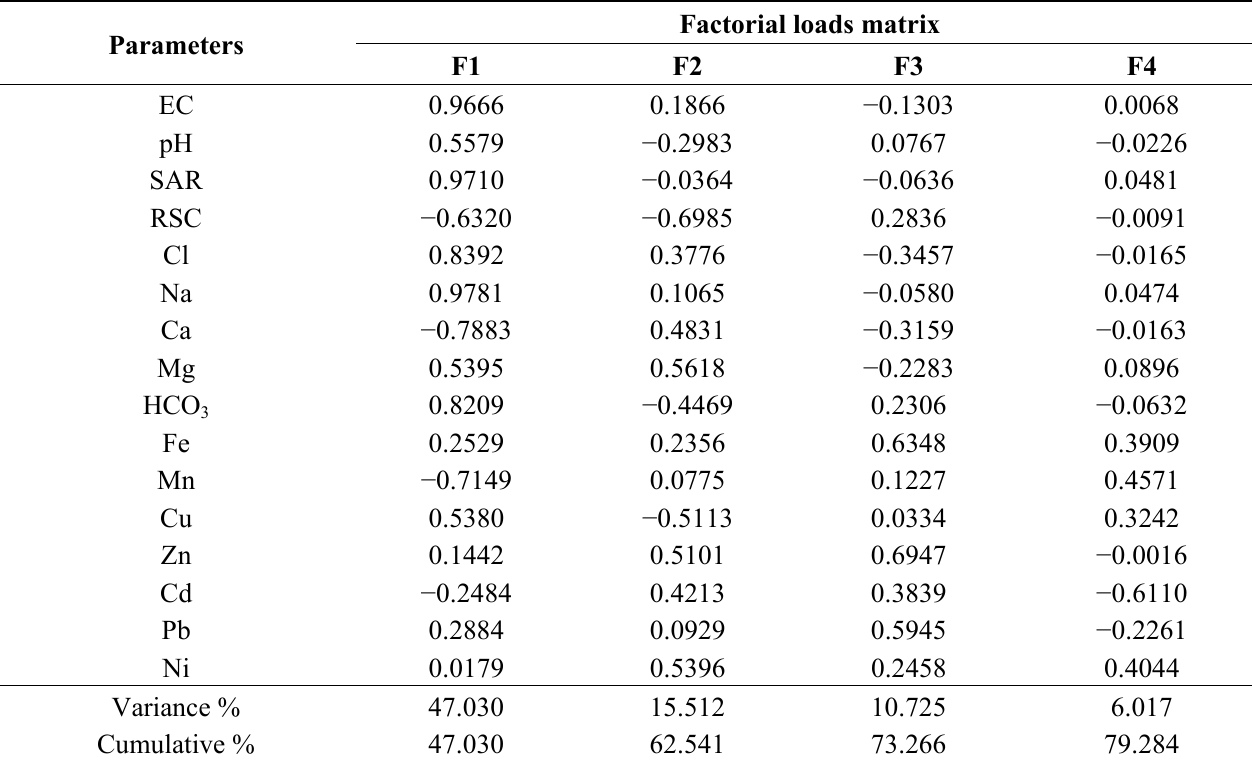
Table 5. Factorial loads for the observed